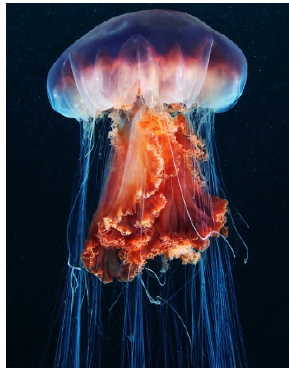
Figure 13. An indivividual of Cyanea capillata © Alexander Semenov; https://www.flickr.com/. Rhopilema esculentum (Kishinouye, 1891; Scyphozoa, Rhizostomeae: Rhizostomatidae; Figure